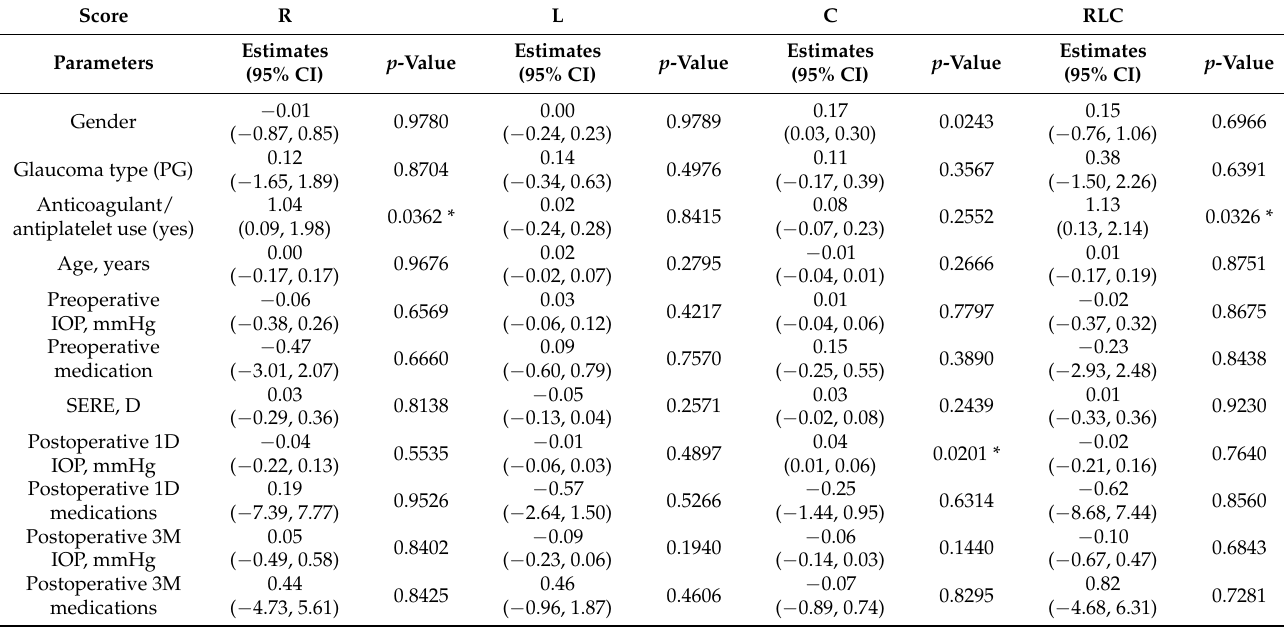
Table 8. Possible associations between postoperative 1D RLC scores and various parameters analyzed by a multiple regression model in iStent-CE